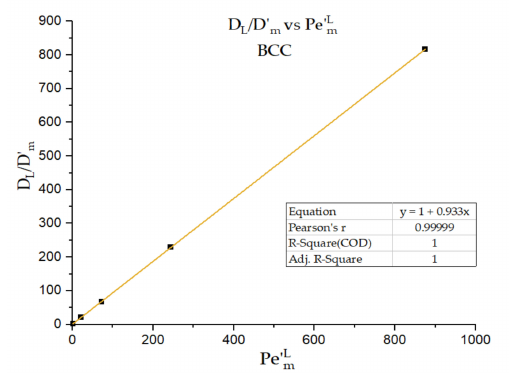
Figure 8. The ratio of hydrodynamic dispersion coe ffi cient over the e ff ective molecular di ff usion coe ffi cient in BCC-packed bed dependence on an e ff ective Lagrangian Peclet